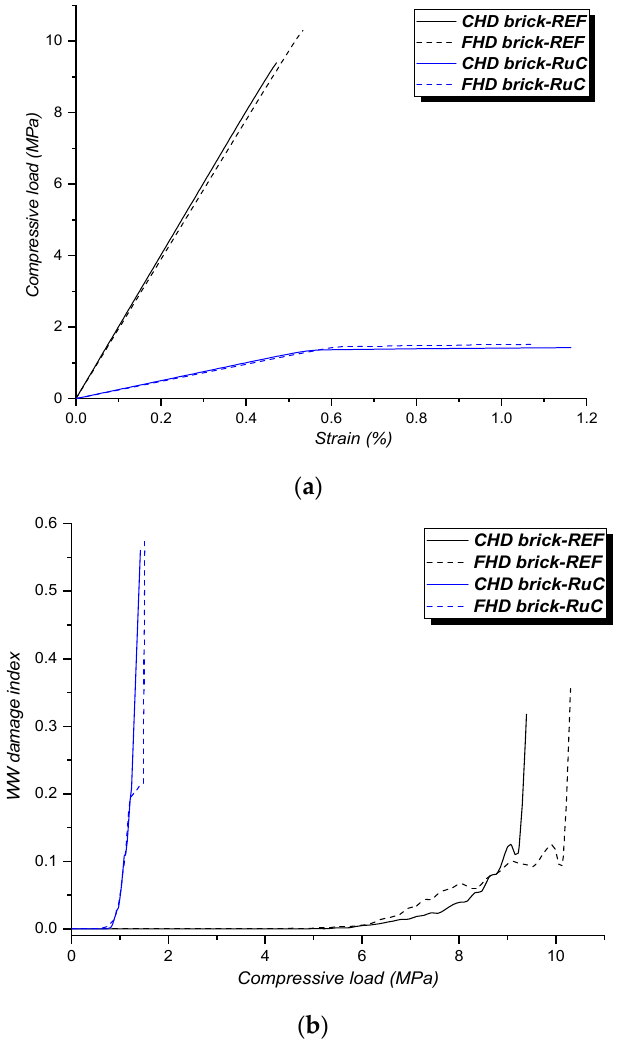
Figure 14. FEA-based mechanical results: ( a ) load–strain curves and ( b ) WW damage index–strain curves.